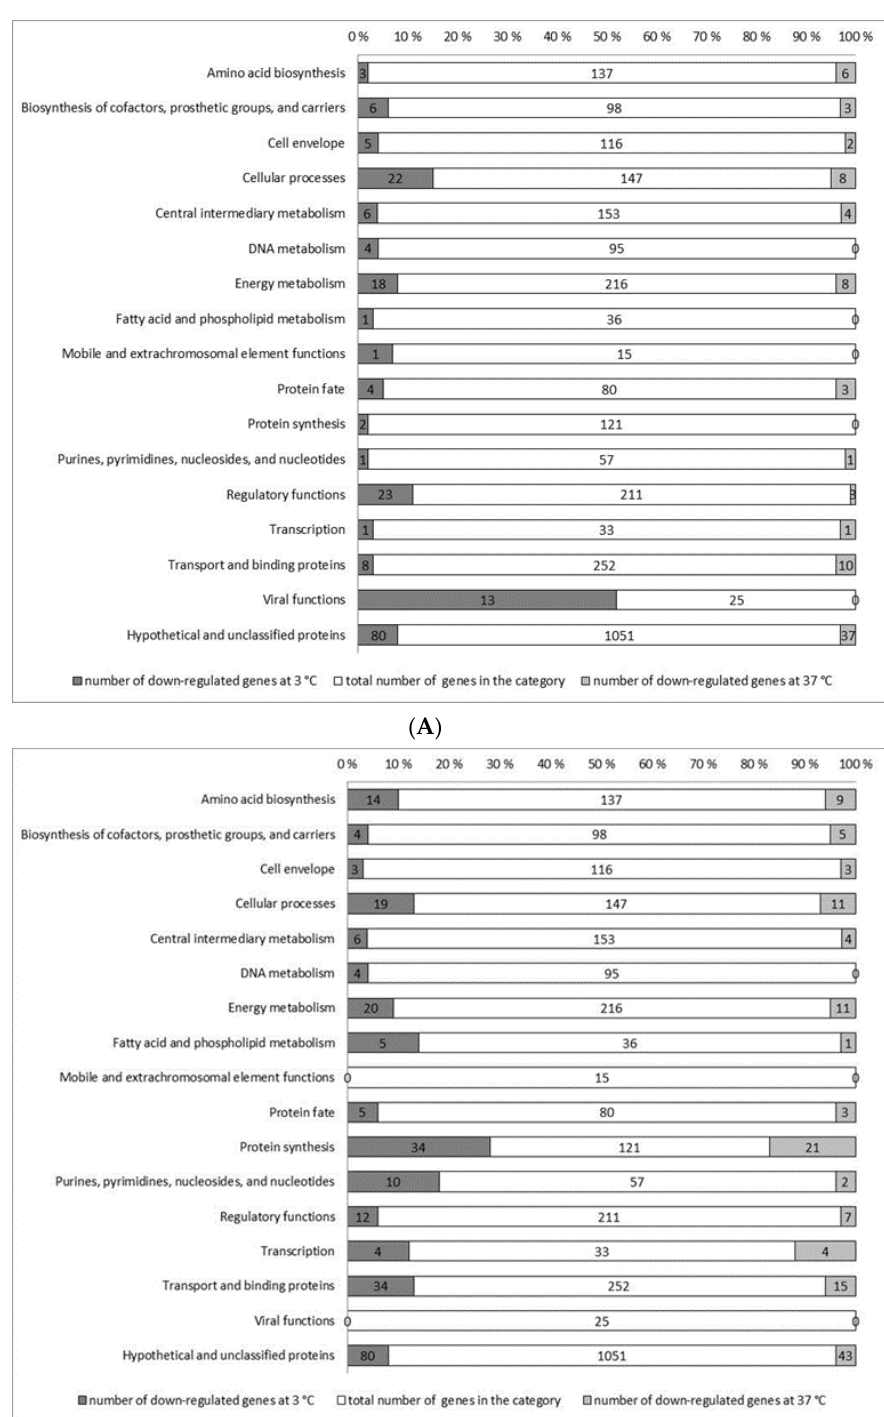
Figure 2. Distribution of significantly down-regulated genes in Listeria monocytogenes ∆ sigB ( A ) and ∆ sigBL ( B ) during exponential growth in BHI at 3 and 37 °C in functional categories. The bar lengths represent the percentage of affected and unaffected genes assigned to each functional category. The genes were grouped into functional categories based on the annotations provided by the Comprehensive Microbial Resource of the J. Craig Venter Institute (CMR-JVCI) (http://cmr.jcvi.org).